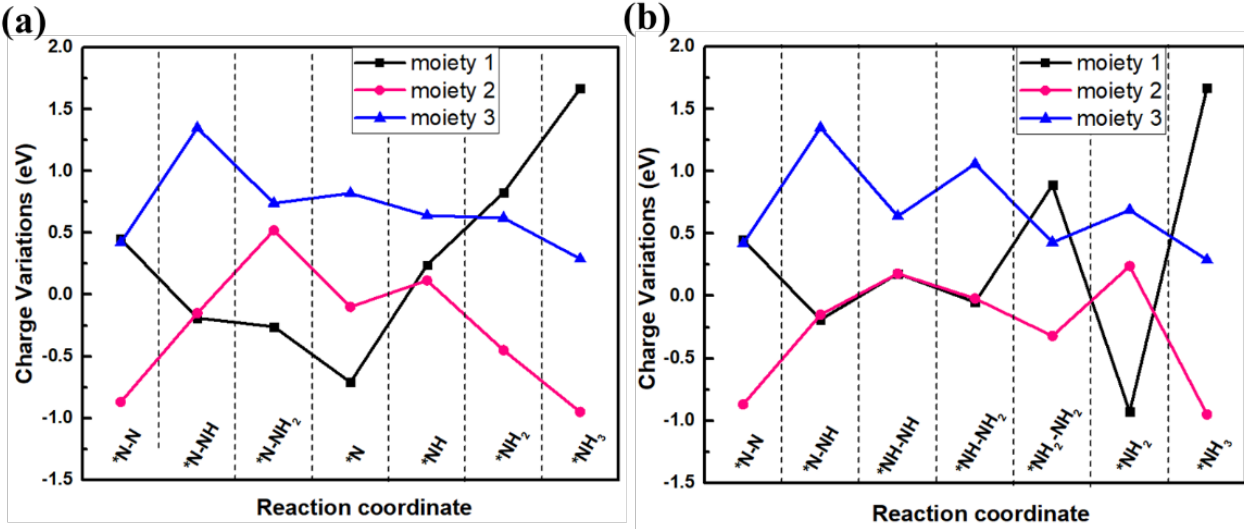
Figure 7. Charge variation diagrams of adsorbates via ( a ) distal and ( b ) alternating mechanism.